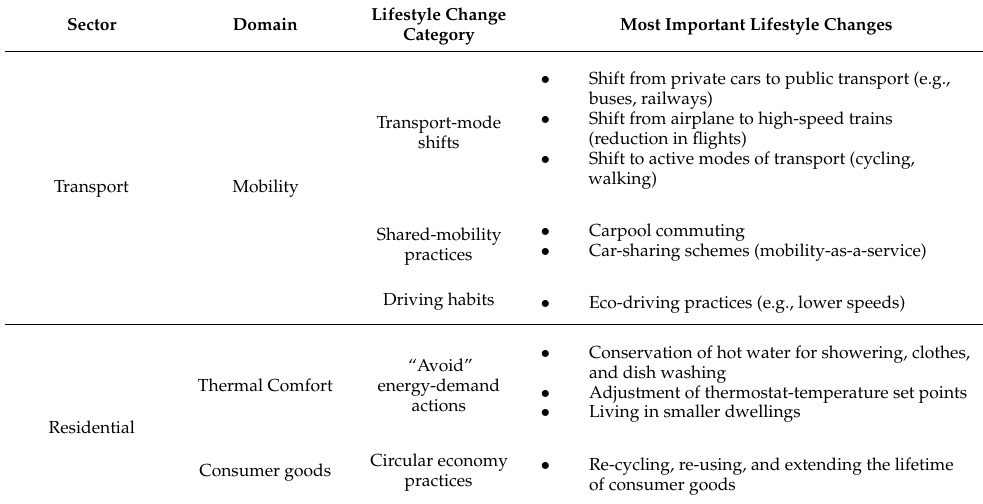
Table 3. Summary of most important lifestyle changes for energy-system and IAM-based modeling studies for the transport and residential